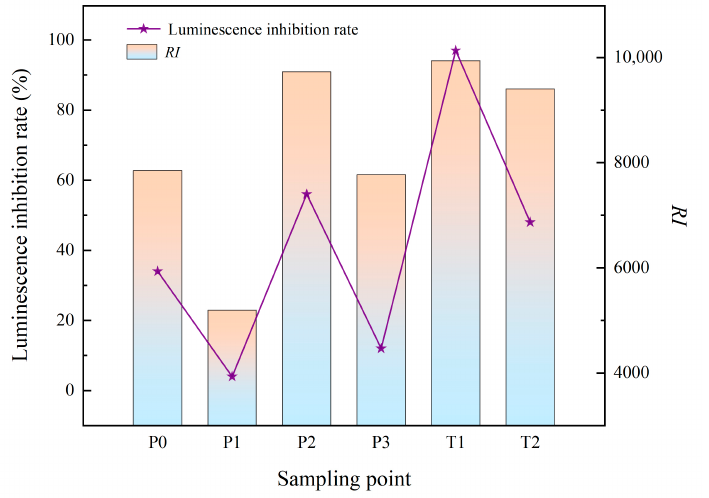
Figure 5. Diagram of the RI value of the potential ecological risk and luminescence inhibition rate of Vibrio fischeri.